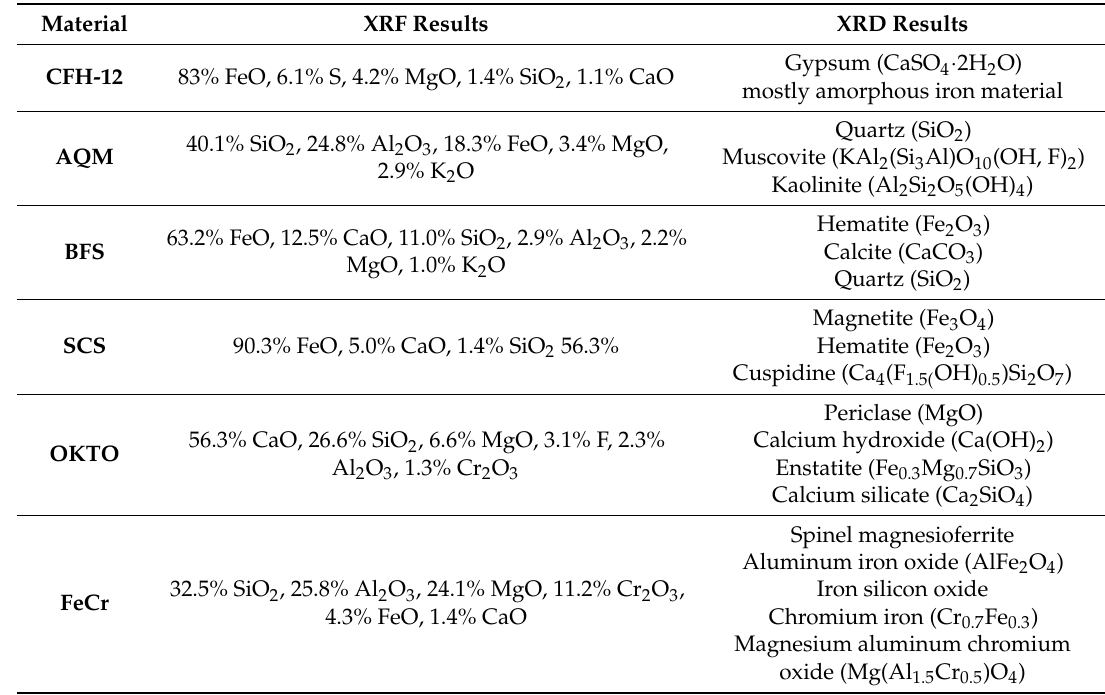
Figure 6. Mechanism of vanadate bonding to the surface of metal (hydr)oxide adsorbents proposed by Naeem et al. [68]. Table 2. Iron sorbents used for vanadium removal by Leiviskä et al., reproduced from [72]. Commercial iron sorbent (CFH-12), commercial mineral sorbent (AQM), blast furnace sludge (BFS), steel converter sludge (SCS), ferrochrome slag (FeCr), and slag from a steel foundry